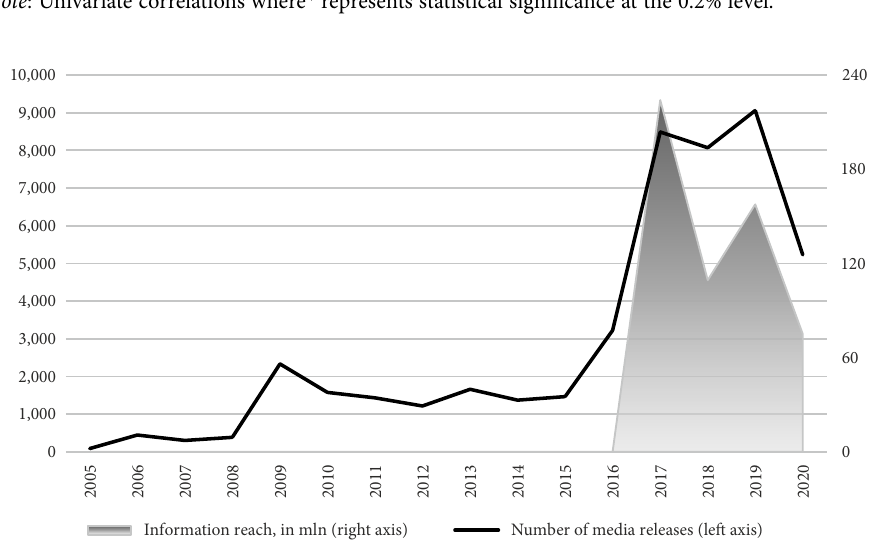
Figure 2. Number and information reach of media releases on protectionism in the Polish media between January 2005 and December 2020 (source: authors’ own elaboration based on data from the information agency,